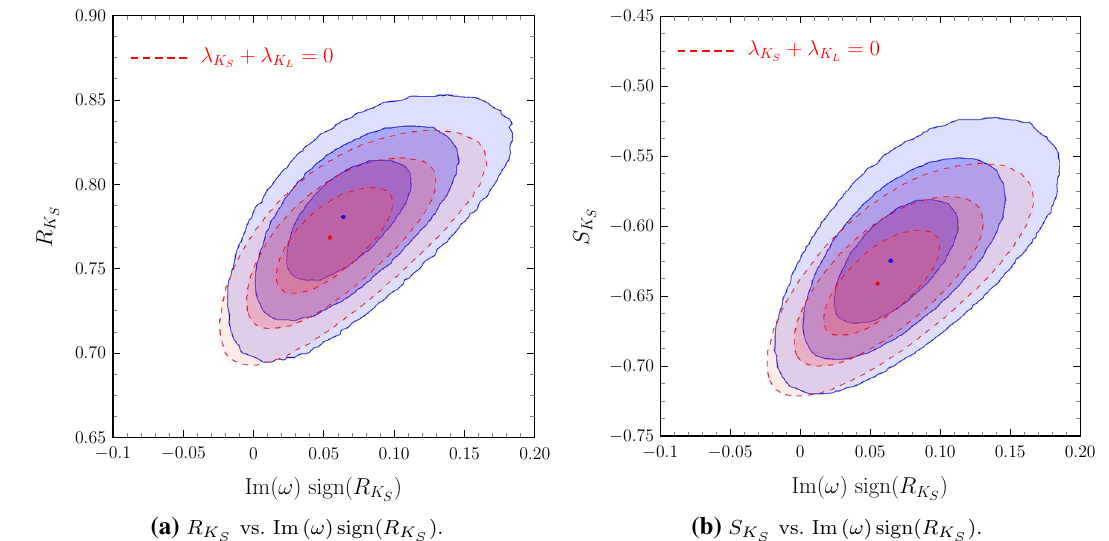
Fig. 4 R K Im (ω) sign ( R K